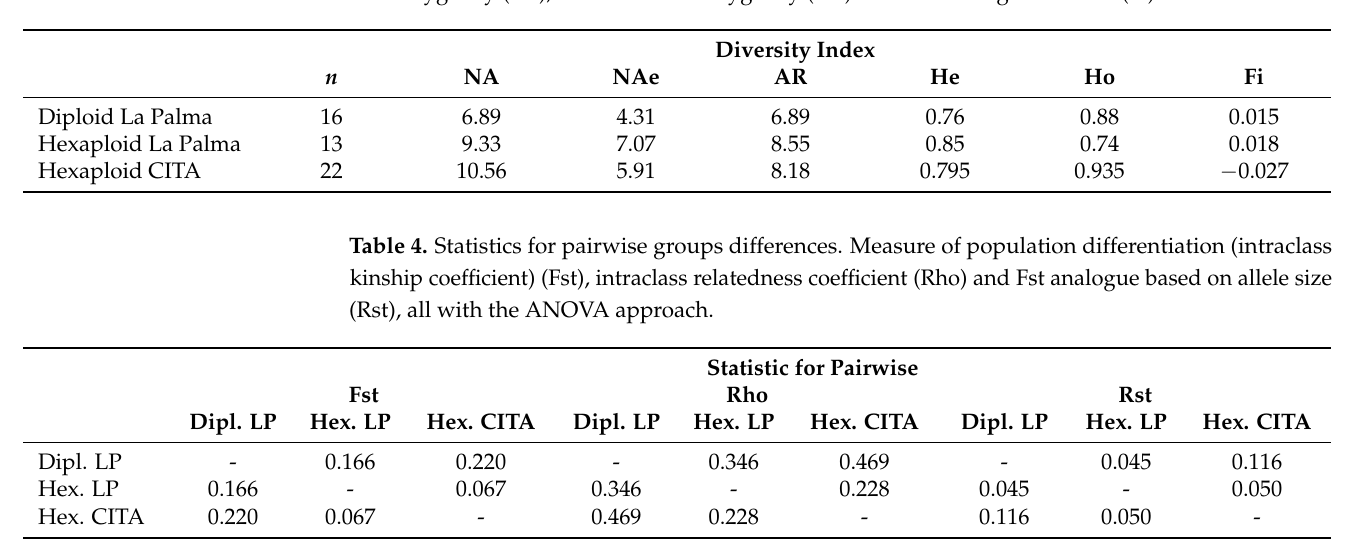
Table 3. Diversity indices for La Palma diploid accessions and La Palma and CITA hexaploid accessions. Number of alleles per locus (NA), average of effective number of alleles (NAe), expected